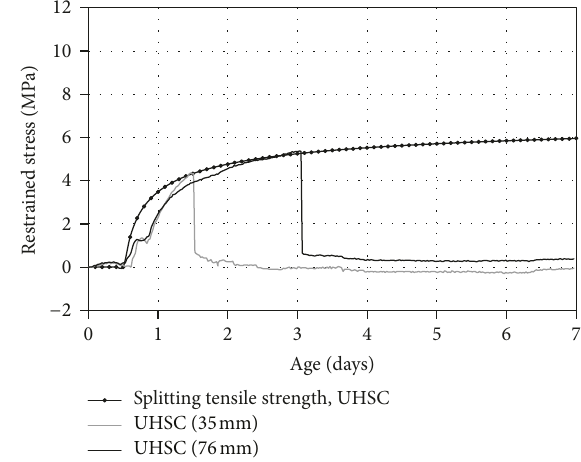
Figure 13: Maximum restrained stress of concrete ring with differ- ent